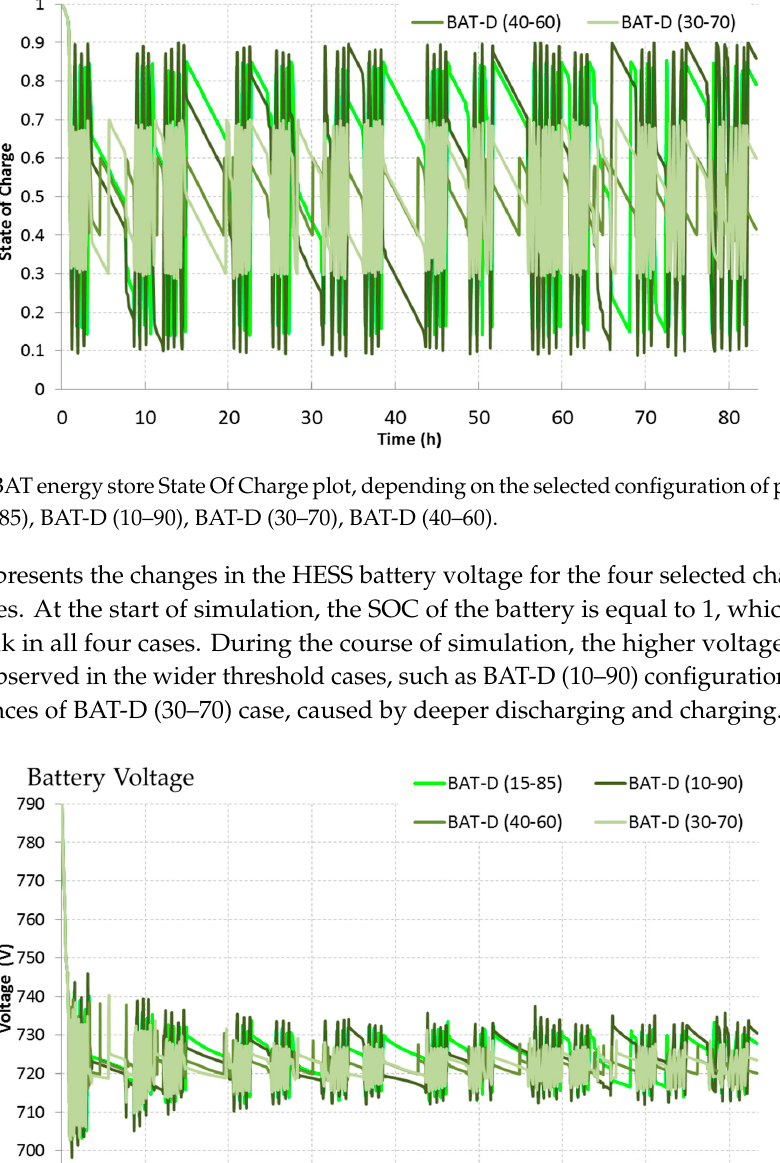
Figure 21. Time plot of consumed fuel energy, depending on the selected configuration of powertrain: Diesel, BAT-D (15–85), BAT-D (10–90), BAT-D (30–70), BAT-D (40–60), FC-BAT-D (15–85).